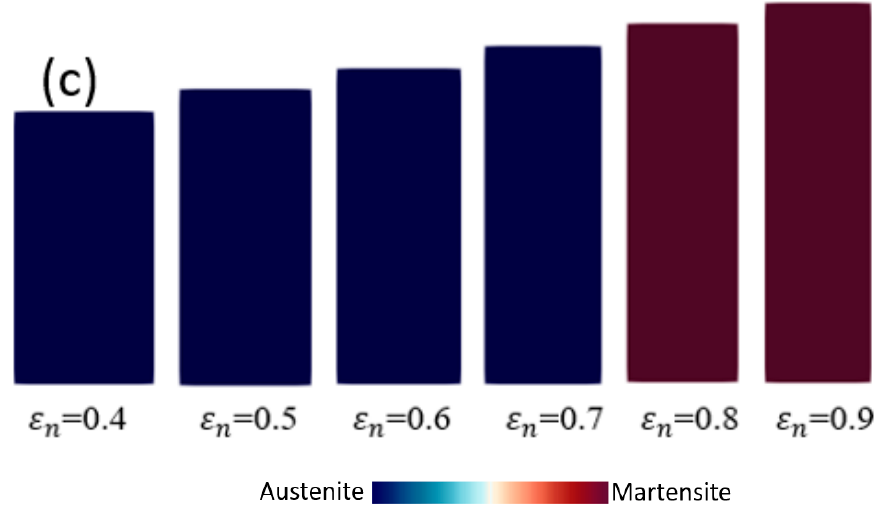
Figure 7. The distribution of martensitic phase of single crystal TRIP steel with initial crystallographic orientations of ( a ) ∅ = 30 ° , ( b ) ∅ = 60 ° and ( c ) ∅ = 90 ° .